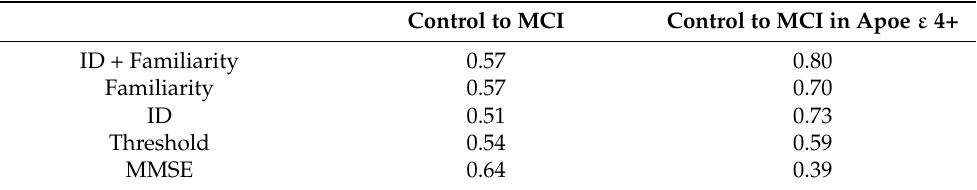
Table 2. AUC values for odor measures and MMSE: Controls converting to MCI.